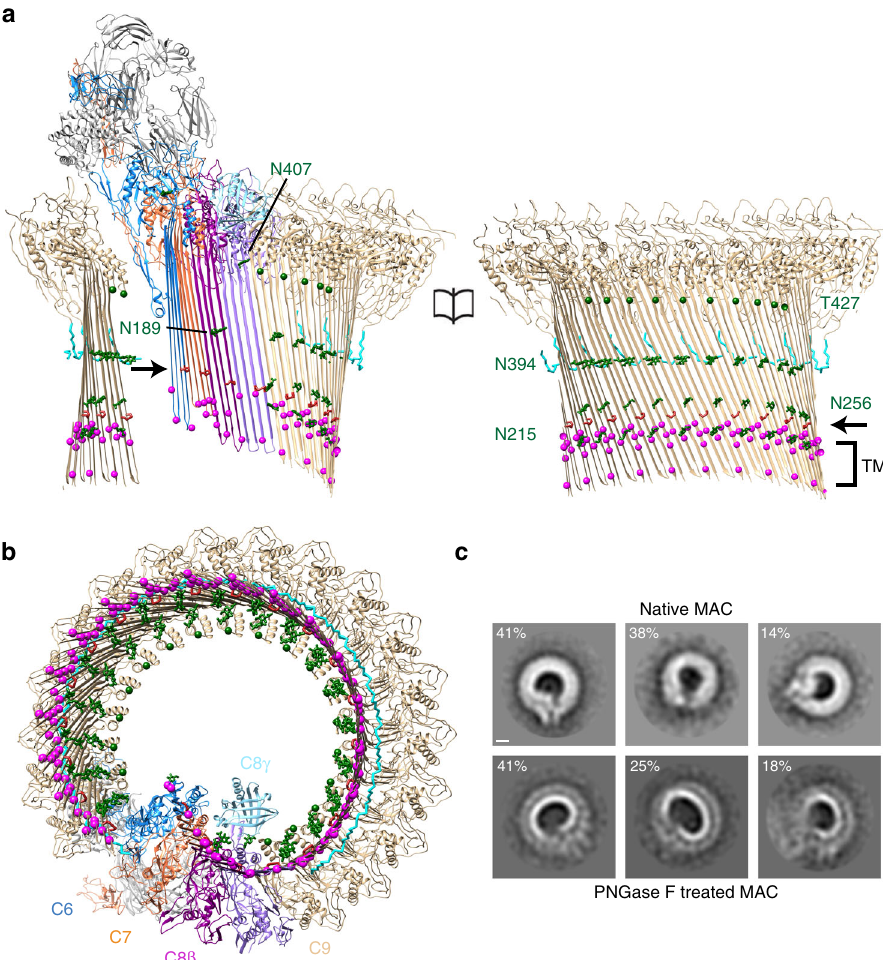
Fig. 2 Glycans provide structural support for a giant β -barrel. Molecular model for the open conformation as viewed from within the β -barrel ( a ) and from the membrane ( b ). N-linked glycans (green) are shown as sticks (C9:N215, N256, N394; C8 β :N189; and C8 α :N407). C α carbons of O-linked C9:T427 are represented as green spheres. Backbone trace of C9 C-terminus (res 522:535) is shown as cyan sticks. Disul fi de bonds within MACPF domains are red and indicated by an arrow. C α carbons of aromatic residues near the membrane (TM) are magenta spheres. c Reference-free 2D class averages of negatively stained MAC assembled from de-glycosylated C8 and C9 (bottom panel) show distorted pores on lipid monolayers as compared to native MAC (top panel). Classes are derived from similar particle numbers to enable a more direct comparison of curvature distortion (native, 706; de-glycosylated,